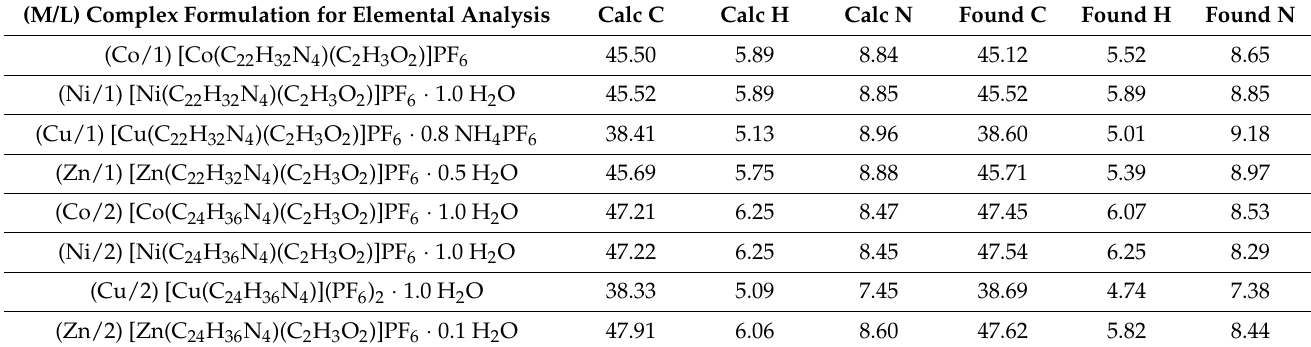
Table 7. Formulas and elemental analyses of ligand 1 and 2